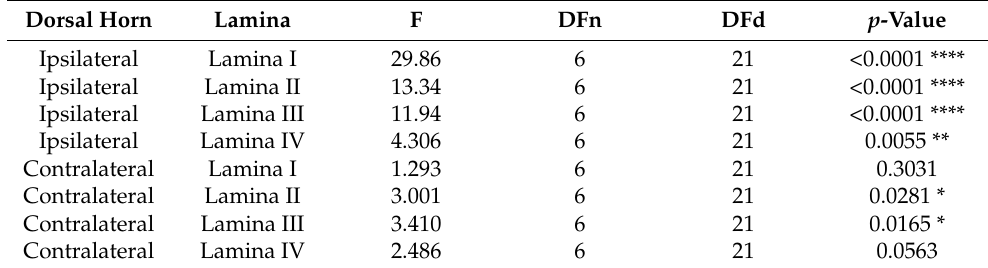
Table 2. ANOVA table for Iba1-positive cells per